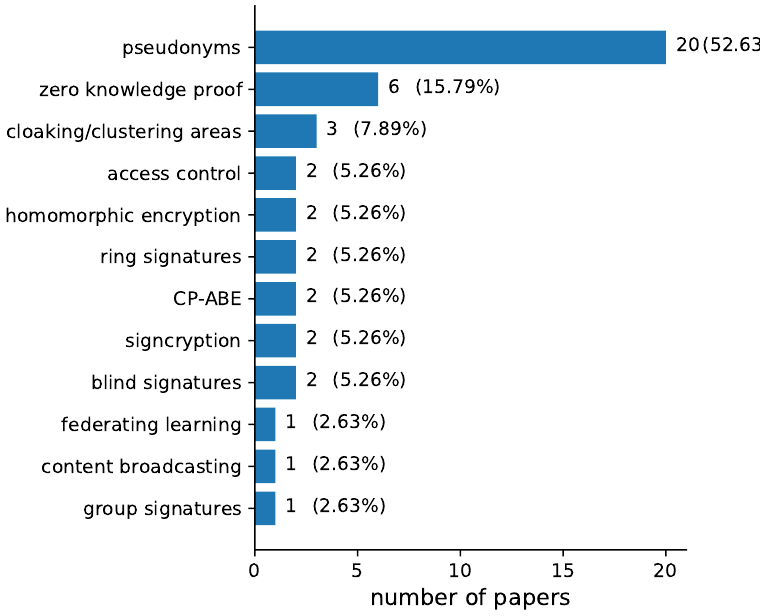
Figure 9. Privacy mechanisms (RQ5) addressed in the papers included in our review.